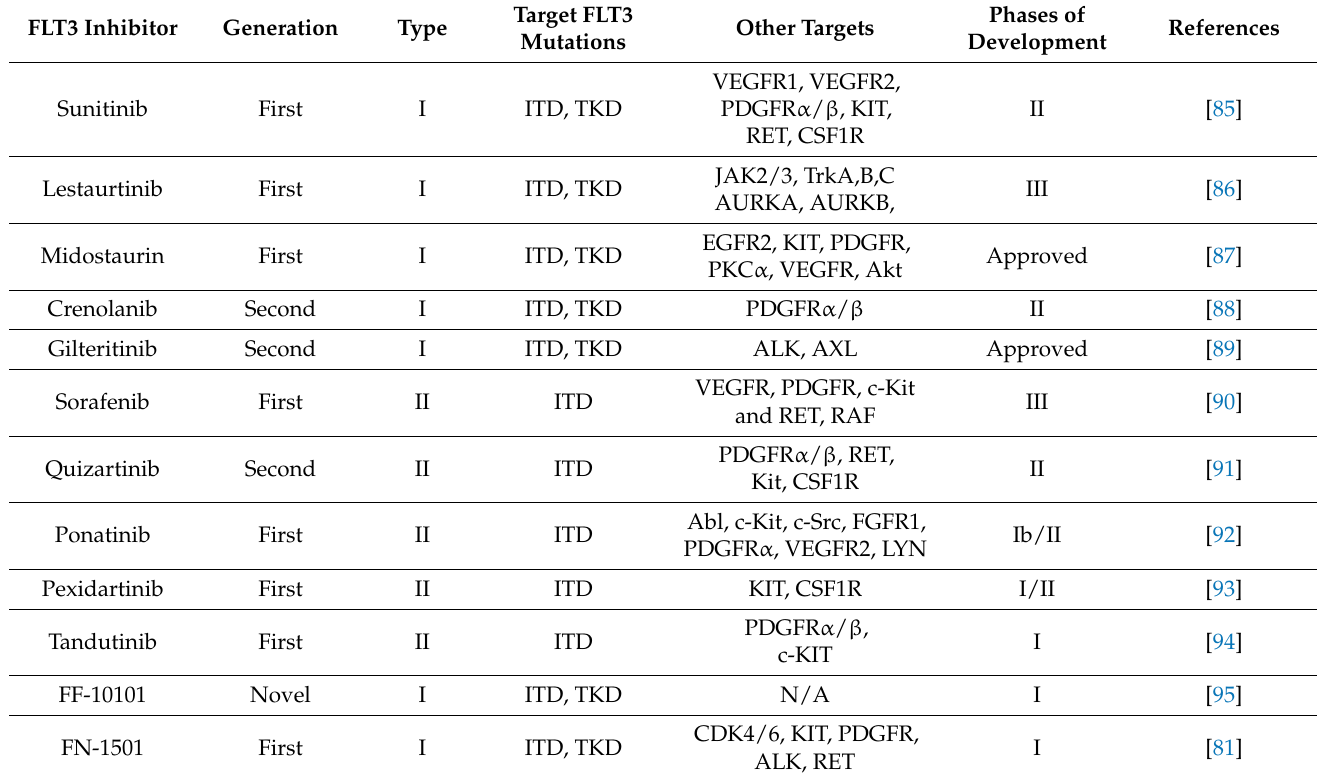
Table 2. FLT3 inhibitors and their